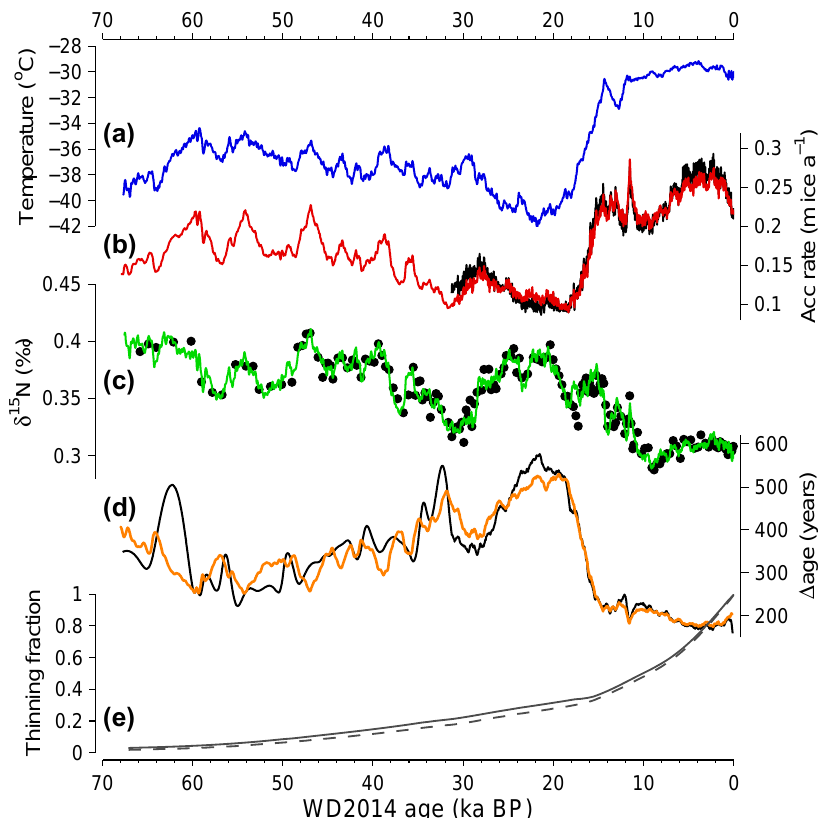
Figure 1. Modeling (cid:49) age for WAIS Divide. (a) Past temperatures reconstructed from water δ D, calibrated to the borehole temperature profile. (b) Past accumulation rates as reconstructed by the firn densification inverse model (red), and from the annual-layer count (black). (c) δ 15 N data (black dots) with densification model output (green). (d) (cid:49) age calculated using the densification model (orange) and using the Parrenin (cid:49) depth method (black) with constant 4m thick convective zone and no correction for thermal δ 15 N fractionation. (e) Modeled thinning function from ice-flow model (solid), and a simple Nye strain model for comparison (dashed); the Nye thinning function, which has a uniform strain rate as a function of depth, is given as f λ (z) = (H − z)/H with H the ice sheet thickness (Cuffey and Paterson, 2010, p.